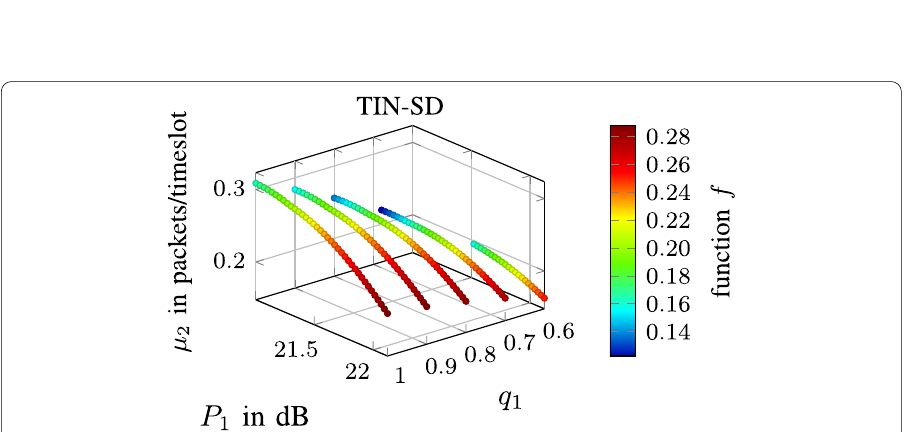
Fig. 8 ( µ 2 , function f aw ) versus ( q 1 , P 1 ), under congestion-aware randomized policy in TIN-SD. The rest of the parameters are the following: (cid:31) 1 = 0.1 , γ 1 = − 4.2dB , γ 2 = − 6.4dB , α = 2.2 , β = 41dB , P J = 23dB , q 2 = 0.4 , B = 6 packets, P max = 23dB , d 2 = 14.6m , and d 12 = 10m . In TIN-SD, d 1 =